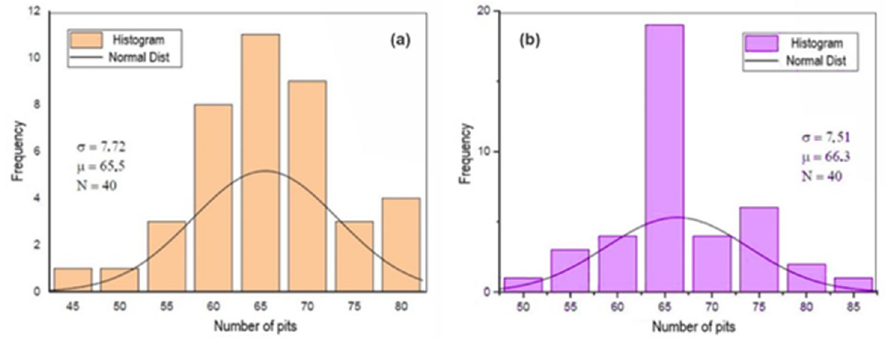
Figure 10. Histogram of the number of pits per analyzed area after the corrosion test for the A1 ( a ) and B1 ( b ) samples.